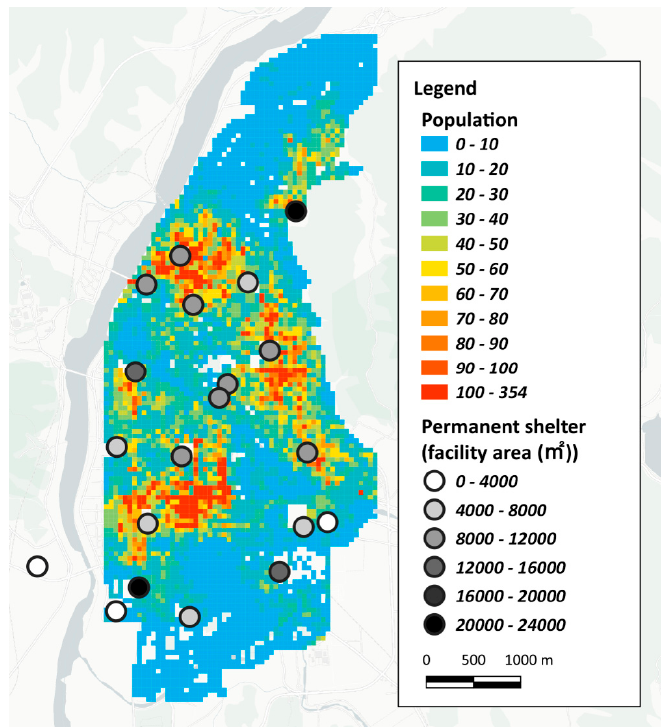
Figure 1. Population distribution at the time of the earthquake, and permanent shelter locations in Gyeongju. People are mostly concentrated in three main districts in the city.